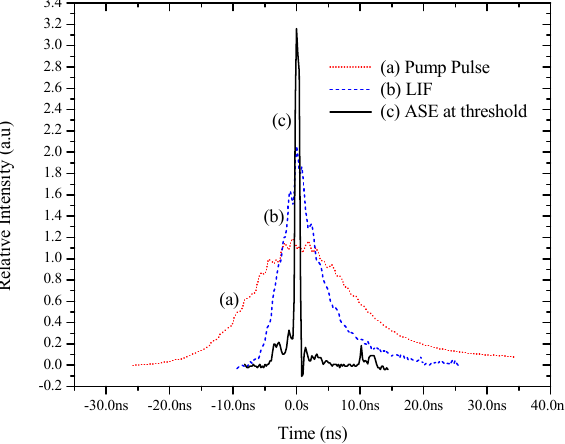
Figure 5. Shows the temporal profile of ( a ) pump pulse; ( b ) LIF and ( c ) ASE, with a full width half maximum (FWHM) of 10, 5 and 1 ns respectively.